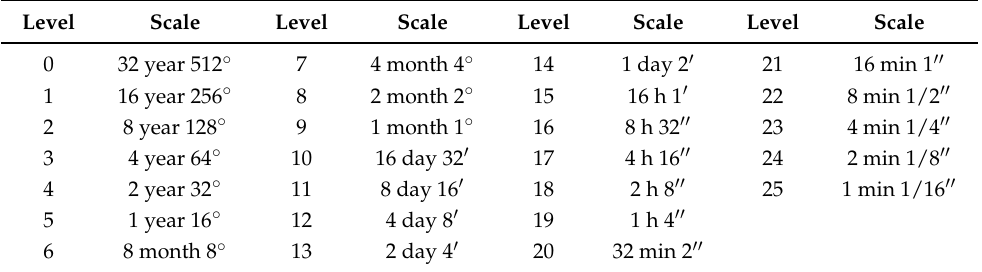
Table 1. The scales of spatio-temporal subdivision corresponding to different levels (if the PeriodLen is 32 years).